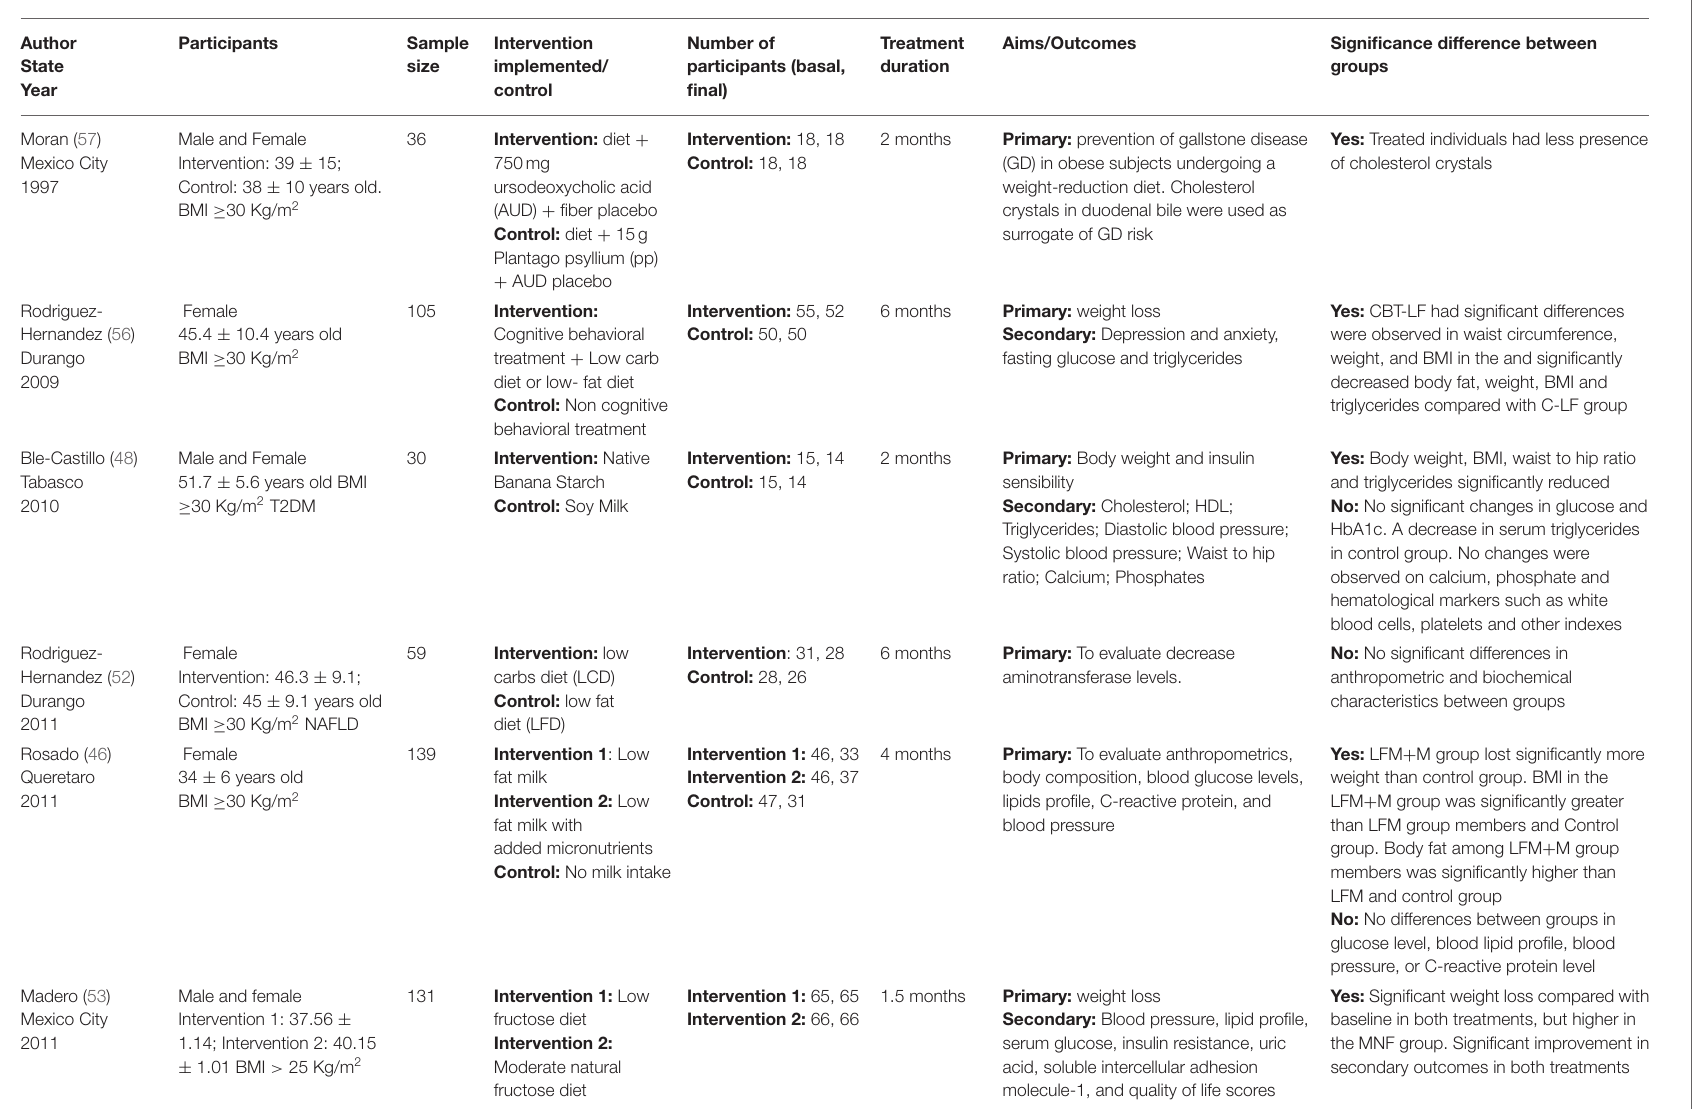
TABLE 2 | Descriptive characteristics and assessment of nutrition/behavioral interventions. Nutritional and behavioral